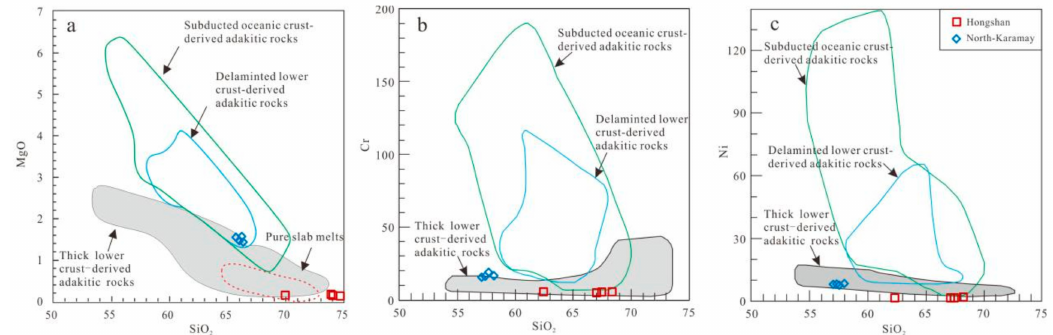
Figure 11. Plots of ( a ) SiO 2 vs. MgO, ( b ) SiO 2 vs. Cr diagram, and ( c ) SiO 2 vs. Ni diagram